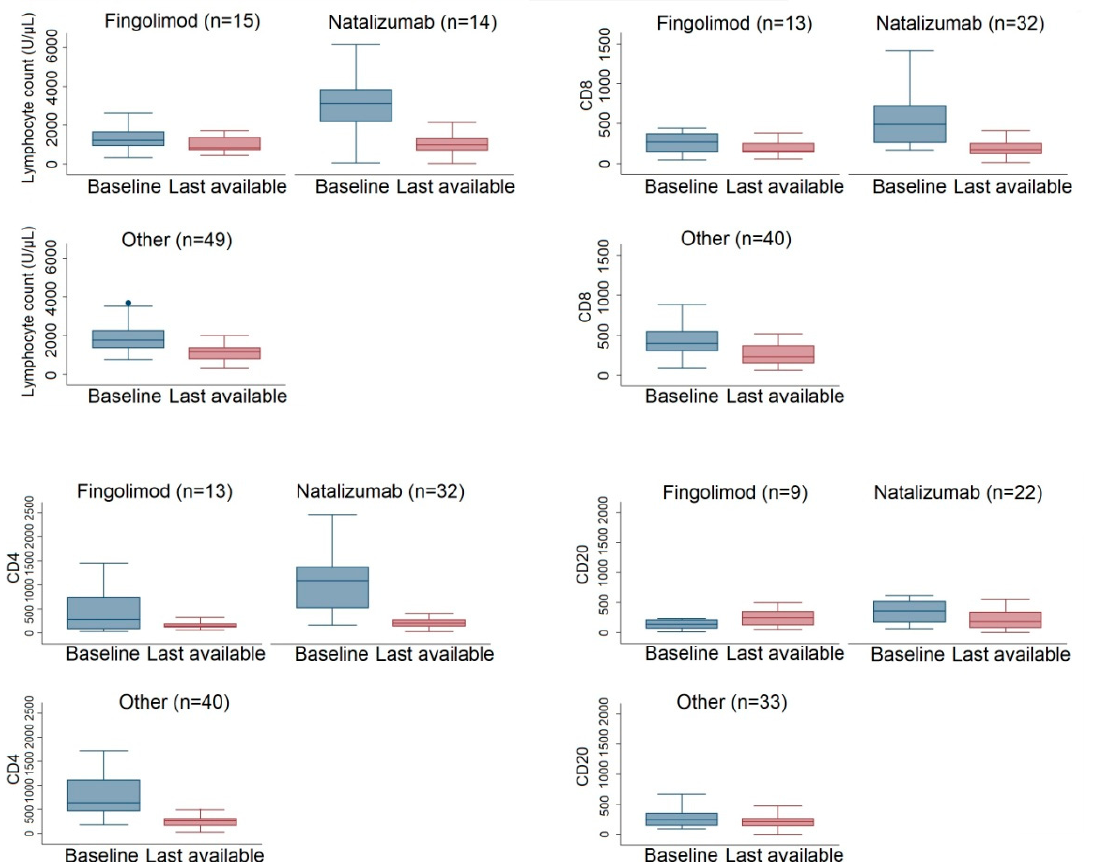
Figure 3. Boxplot of lymphocyte subsets stratified for previous DMTs (fingolimod, natalizumab, or others) at baseline and at the last available observation within 24 months. Data at 24 months were used if available, otherwise 18 months or 12 months were considered.